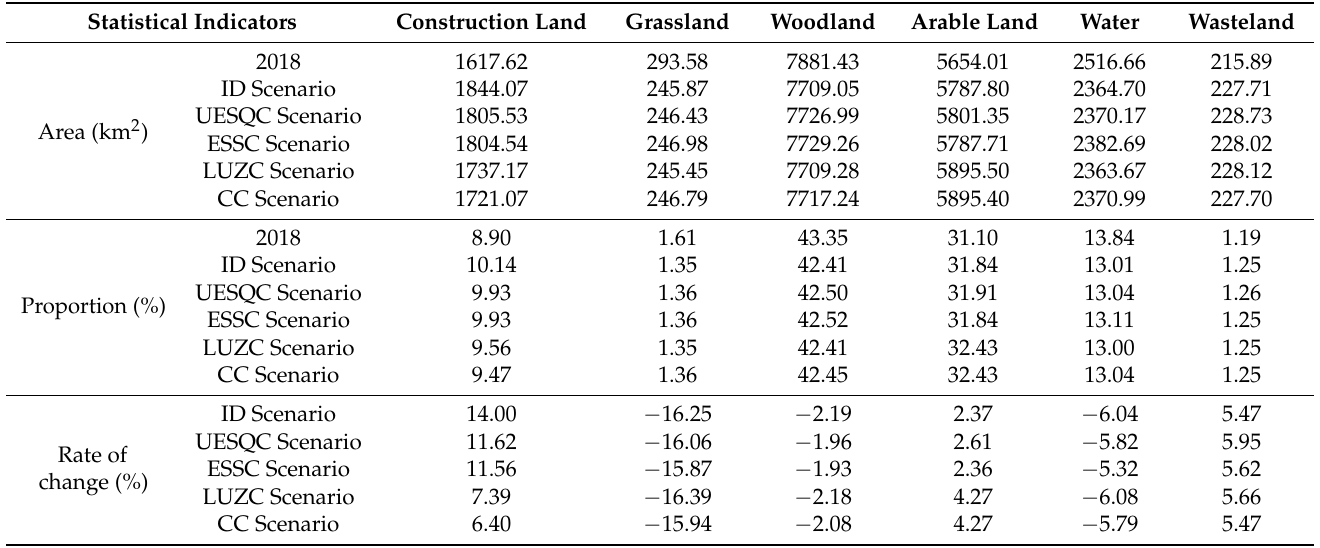
Table 7. Characteristics of Land Use Types in Changde under Different